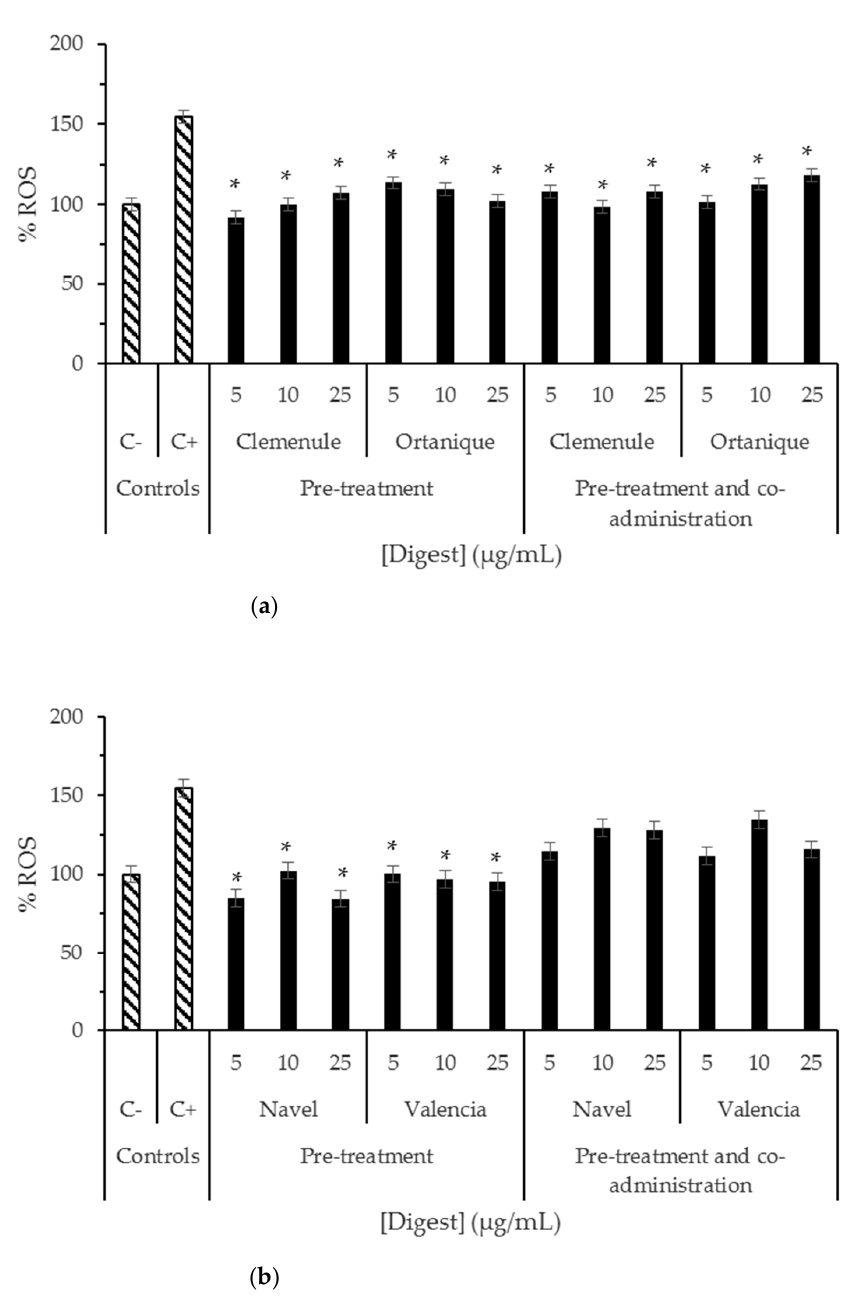
Figure 2. Induced ROS formation in normal small intestinal cells of rats (IEC-6) treated with digests of ( a ) Clemenule and Ortanique mandarin and ( b ) Navel and Valencia orange pomaces prior to oxidative damage. Cells treated with tert-butyl hydroperoxide were used as positive control (C+), while untreated cells were employed as negative control (C − ). The basal production (100%, C-), was significantly increased due to the treatment with tert-butyl hydroperoxide until about 150% (C+). Pre-treatment assay: normal rat small intestinal cells were treated with samples for 24 h followed by administration of the oxidative agent (tert-butyl hydroperoxide) for 30 min. Pre-treatment and co-administration assay: cells were treated with samples for 24 h followed by co-administration of the oxidative agent (tert-butyl hydroperoxide) and sample for 30 min. Bars represent mean values while error bars denote standard error of the mean (SEM). * Indicates statistical differences between mean values with p < 0.05 by Tukey test when compared to the positive control